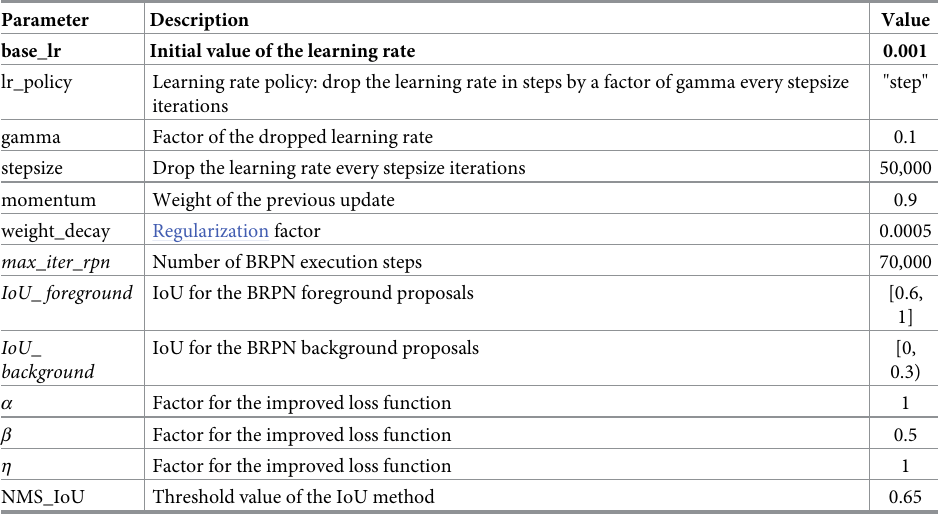
Table 4. BRPN parameters.